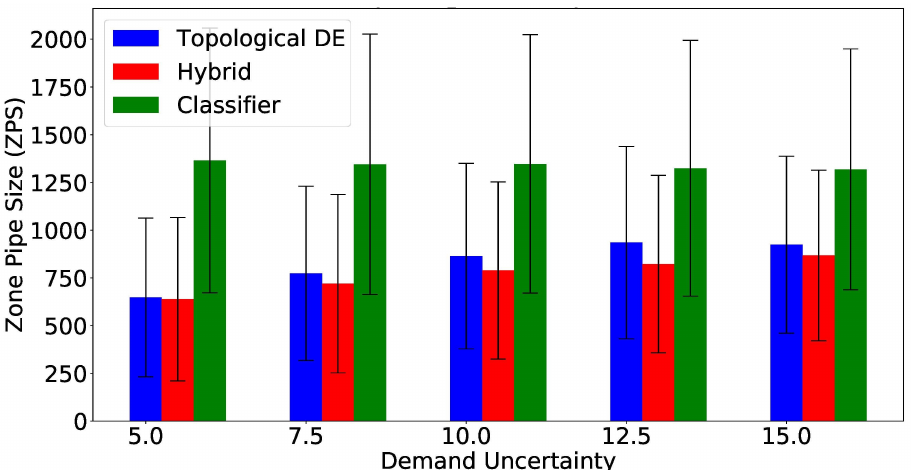
Figure 7. Comparing Zone Size in Total Pipe